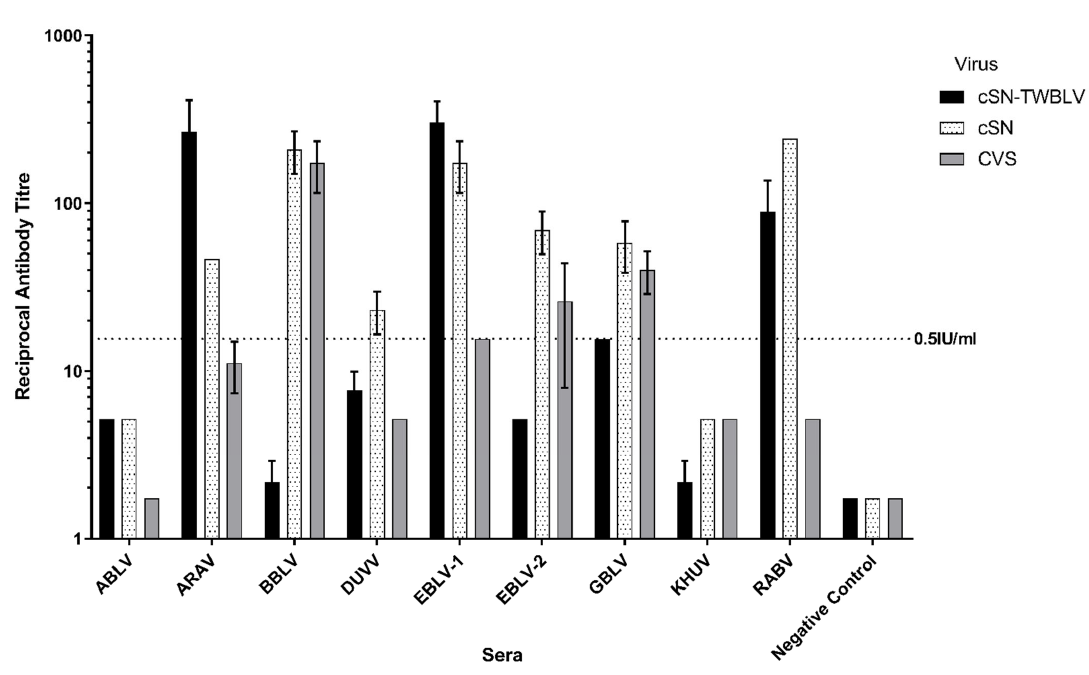
Figure 3. Cross ‐ neutralization profiles of each phylogroup I lyssavirus ‐ specific sera using an mFAVN test. The test was performed in triplicate and as three independent experiments where the mean and standard deviation of the results were plotted on a logarithmic scale. The 0.5 IU/mL neutralization cut ‐ off is dictated by the WOAH sera against CVS (indicated by the dashed line). IRKV sera not shown.